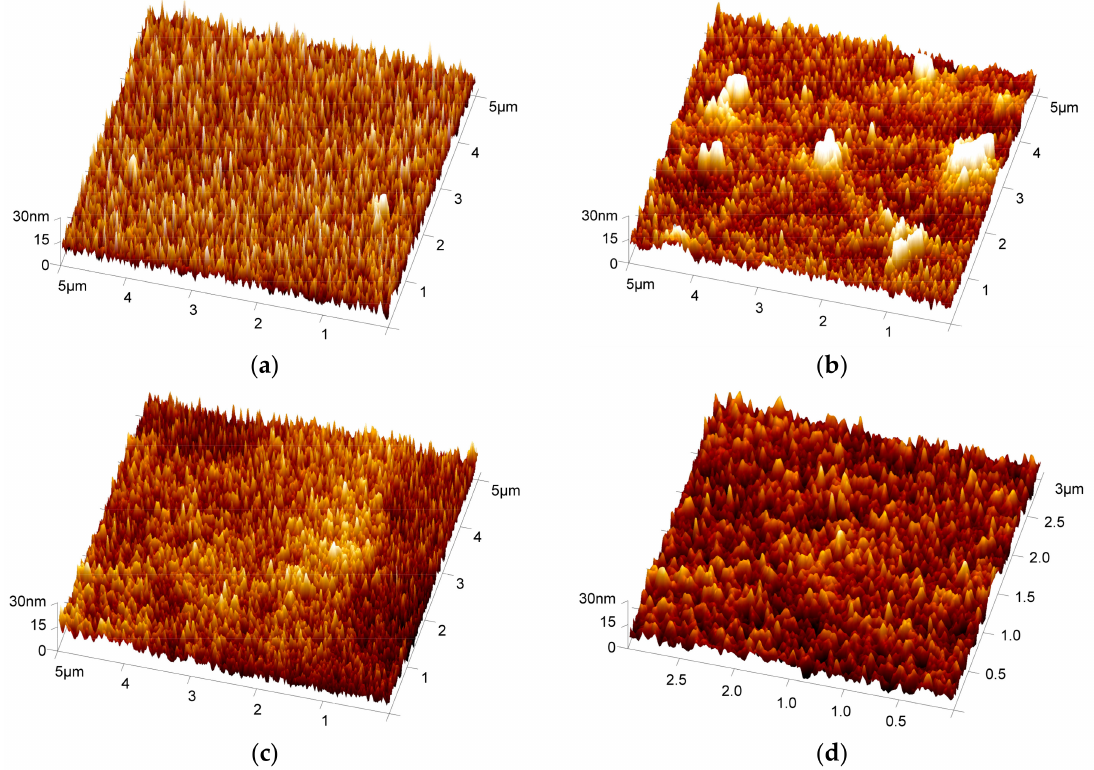
Figure 8. AFM 3D morphology tests for ( a ) deposited Ti substrate, ( b ) GO-APS, ( c ) HRGO-APS (5 µ m × 5 µ m), and ( d ) HRGO-APS coating on the deposited Ti substrate (3 µ m × 3 µ